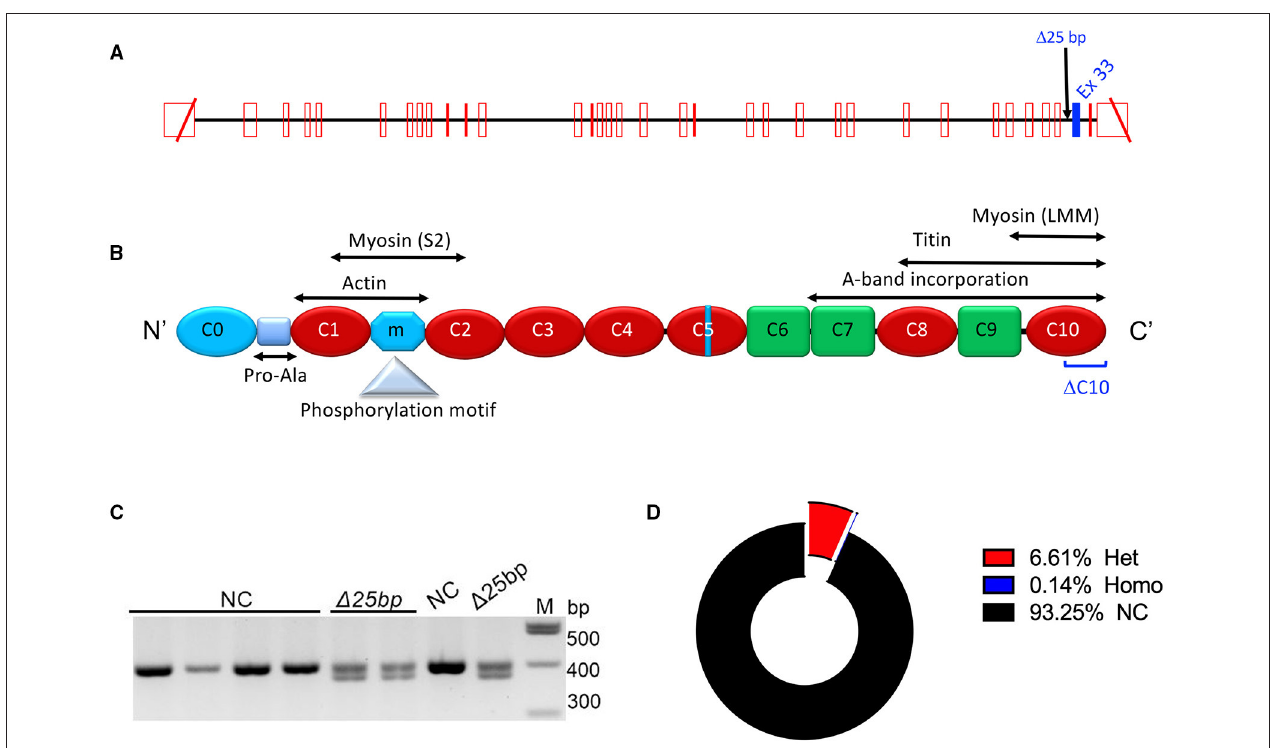
FIGURE 1 | MYBPC3 1 25bp genotyping and prevalence. (A) Schematic diagram of the MYBPC3 gene that includes the location of MYBPC3 1 25bp variant in Intron 32. Exon 33 is highlighted in blue as a potential skipped exon and altered splicing exon when the MYBPC3 1 25bp variant is pathogenic. (B) cMyBP-C domains are drawn with interacting partners, proline-alanine (Pro-Ala)-rich region, phosphorylation motif, and potential C10 domain that could be modified if exon 33 is altered (DC10). (C) Agarose gel electrophoresis of PCR-based genotyping of the MYBPC3 1 25bp variant. (D) MYBPC3 1 25bp distribution of 3,432 South Asian participants. Among carriers of the MYBPC3 1 25bp variant, 6.61% of carriers (227, red color sector) were heterozygous (Het), and 0.14% of carriers (5, blue color sector) were homozygous (Homo). NCs, non-carriers.